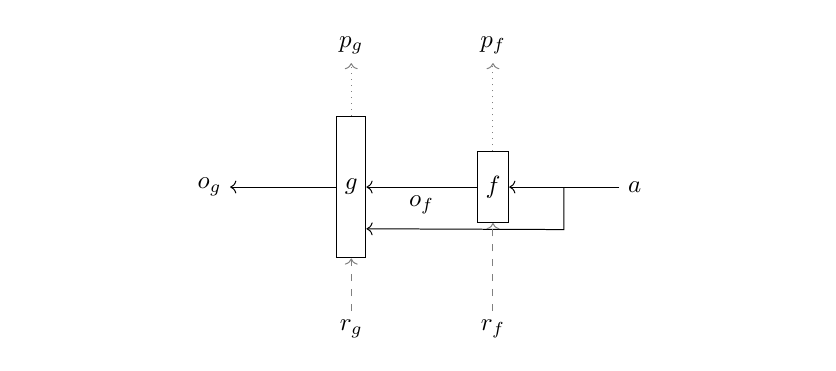
and it is assumed to have been probed at location p g ( a, b, r g ) is the ISW multiplication [ISW03] which consumes 3 random bits r g for the secret computation. Also in this case, it is assumed a single probe p